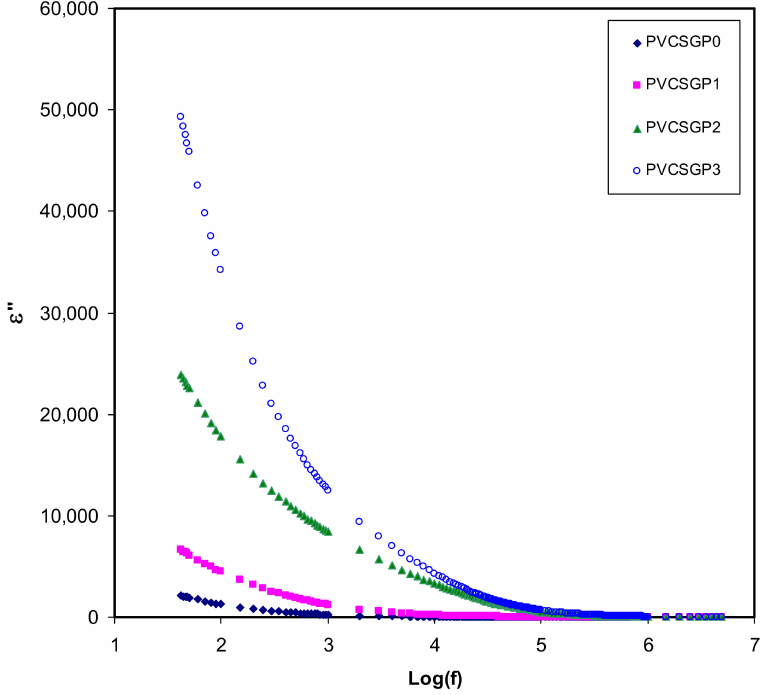
Figure 4. Dielectric loss versus log (f) for all polymer-blend